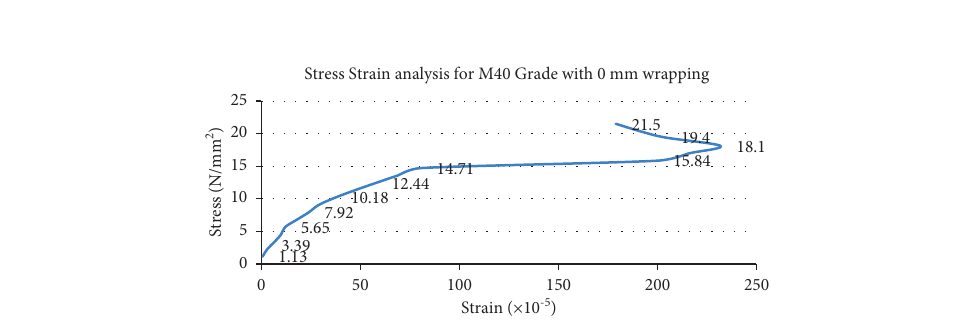
Figure 12: Stress-strain analysis for grade M40 with 0mm wrapping. Table 6: Young’s modulus for M20 grade of column with 3mm